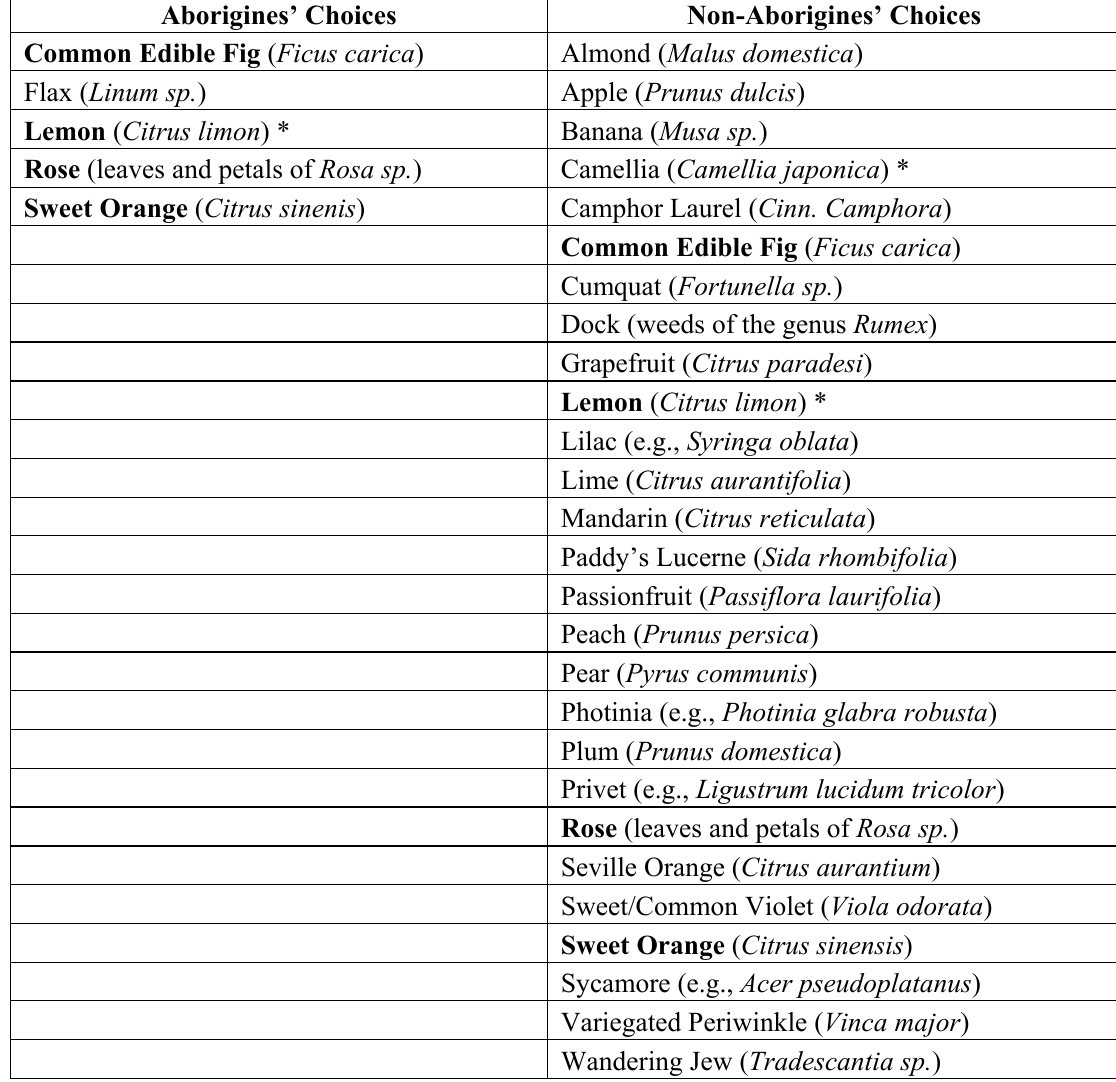
Table 2. Comparative typology of introduced Australian leaf